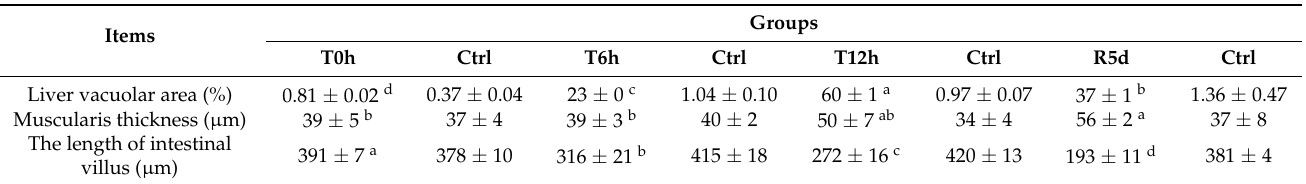
Table 1. Changes in liver vacuolar area, intestinal muscular thickness and villus length in juvenile largemouth bass under transport